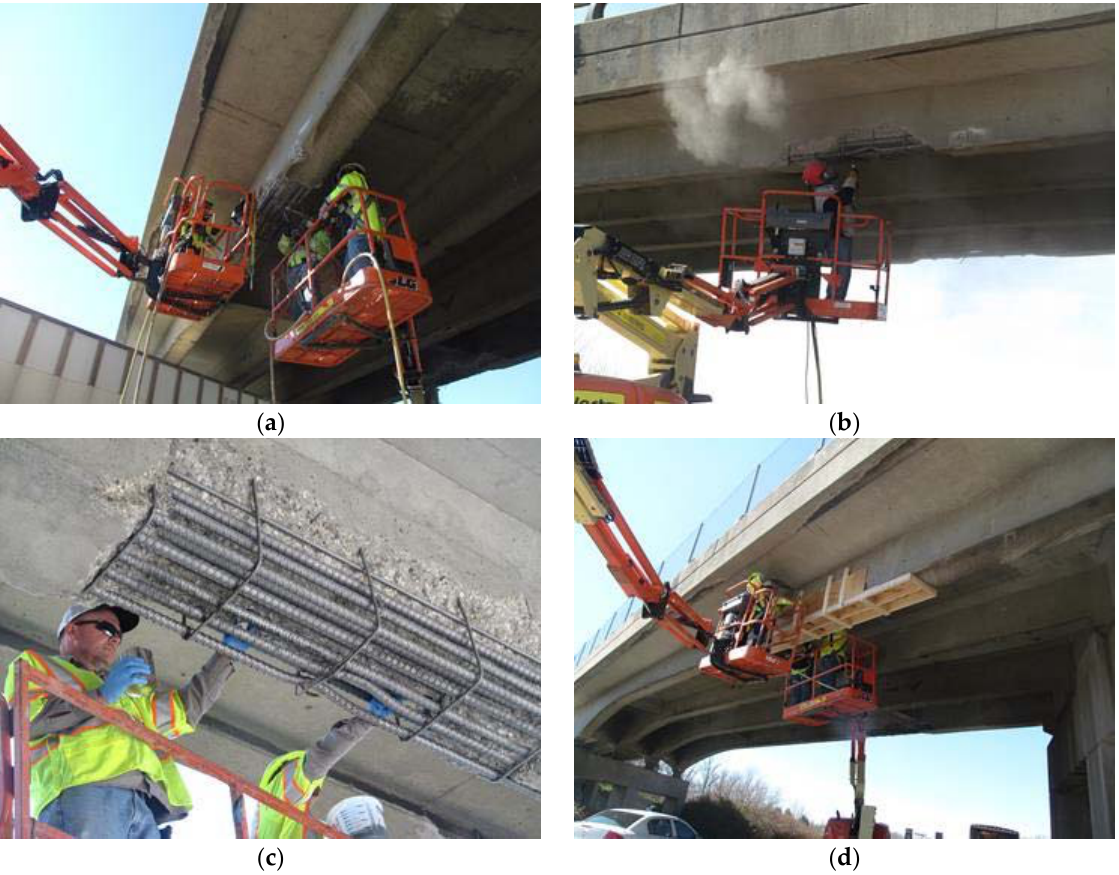
Figure 9. Concrete repair of RC girders ( a ) Remove loose concrete; ( b ) Grit blasting steel rebar; ( c ) Application of primer coating on rebar; ( d ) Setting up formwork for repair mortar.